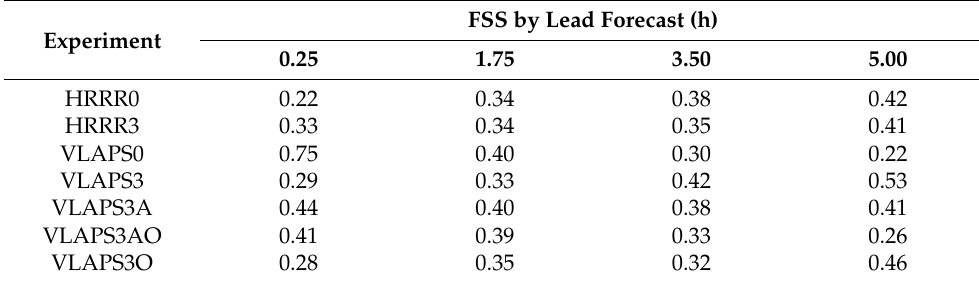
Table 2. FSS for 25 dBZ threshold and 9 km neighborhood size, at four different lead forecast times (h).